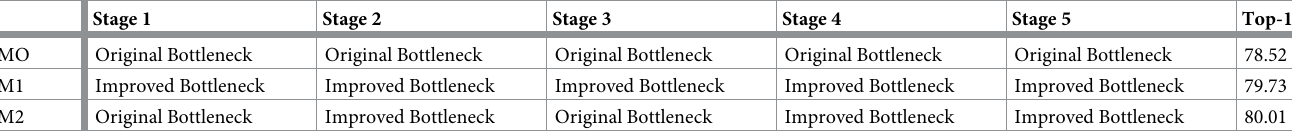
Table 7. Results for different position of improved bottleneck in